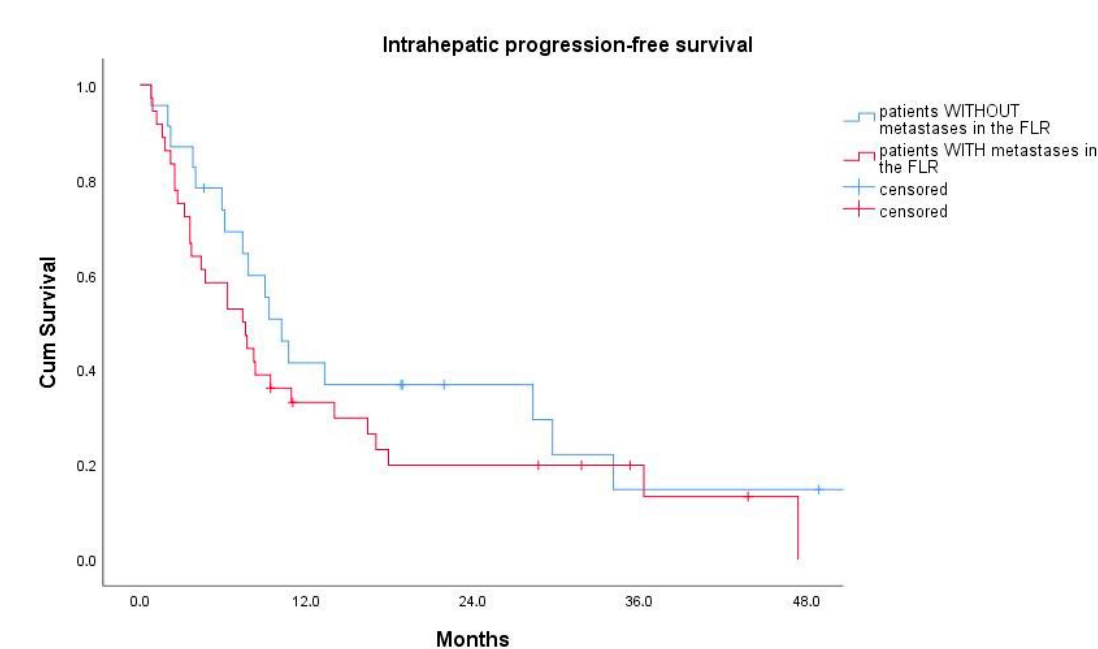
Figure 3. Kaplan–Meier curves for intrahepatic progression-free survival for patients with (red curve) and without (blue curve) liver metastases in the FLR before portal vein embolization.